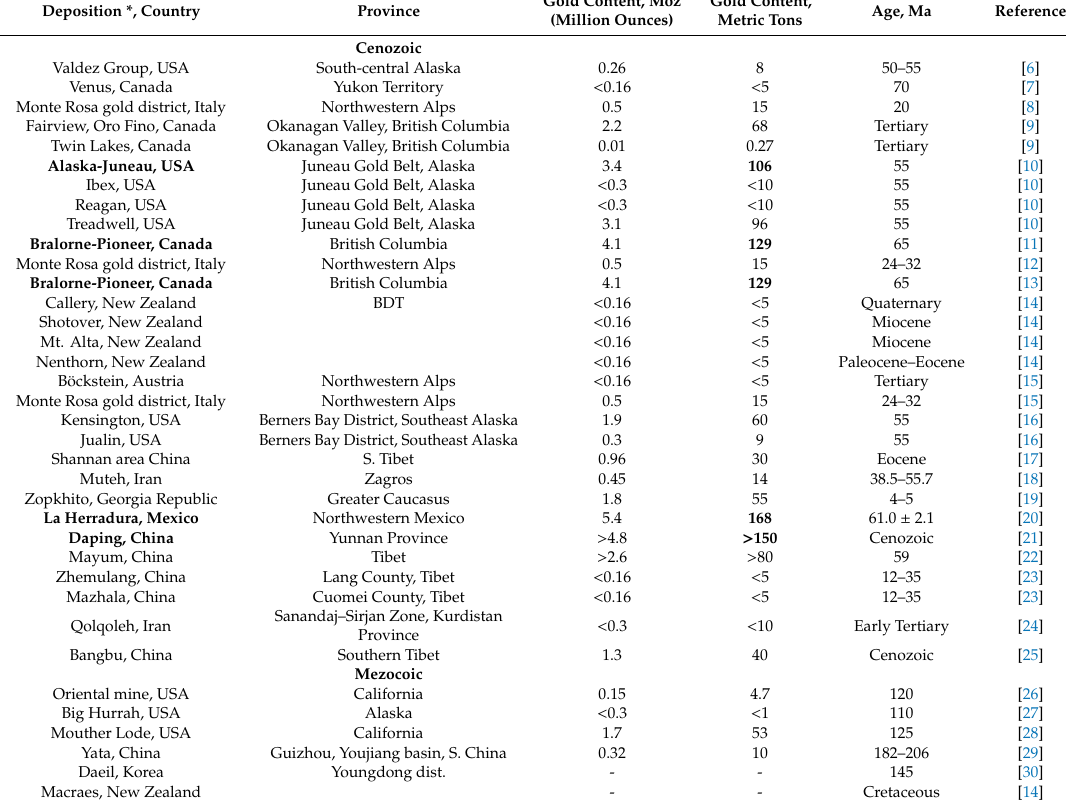
Table 1. Orogenic gold